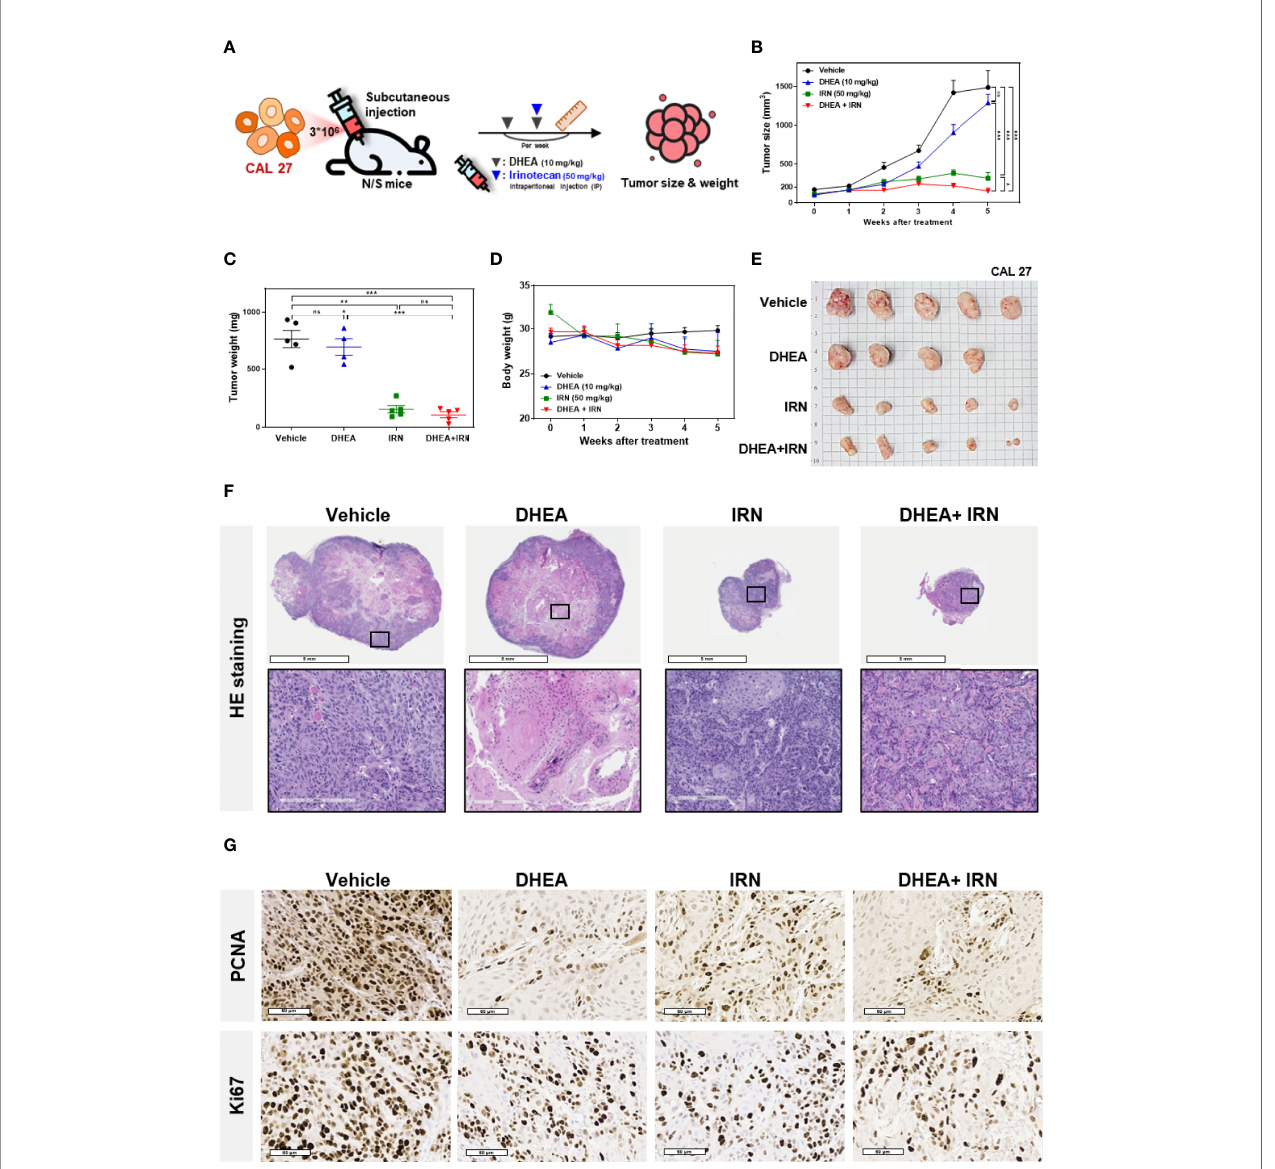
FIGURE 4 | DHEA combined with IRN showed increased anti-tumor effect in HNSCC subcutaneous mouse models. (A) Flow chart showing the experimental schedule and drug administration. CAL 27 cells were subcutaneously injected into mice and then treated with DHEA (10 mg/kg/twice a week) and IRN (50 mg/kg/ once a week) via intraperitoneal injections. Tumor size and body weight were measured once a week. (B – E) Tumor size (B) , tumor weight (C) , body weight (D) , and tumor appearance (E) of CAL 27 tumor-bearing mice in vehicle- and drug-treated groups. (F) Hematoxylin and eosin (H&E) staining results of tumors from mice following vehicle and drug treatment. (G) IHC staining for PCNA ( upper ) and Ki67 ( lower ) in tumors from mice following various treatments. Data represent mean ± SEM ( n = 5/per group). * p < 0.05; ** p < 0.01; *** p < 0.001, n.s. not signi fi cant, compared to each other using t-test . IRN,